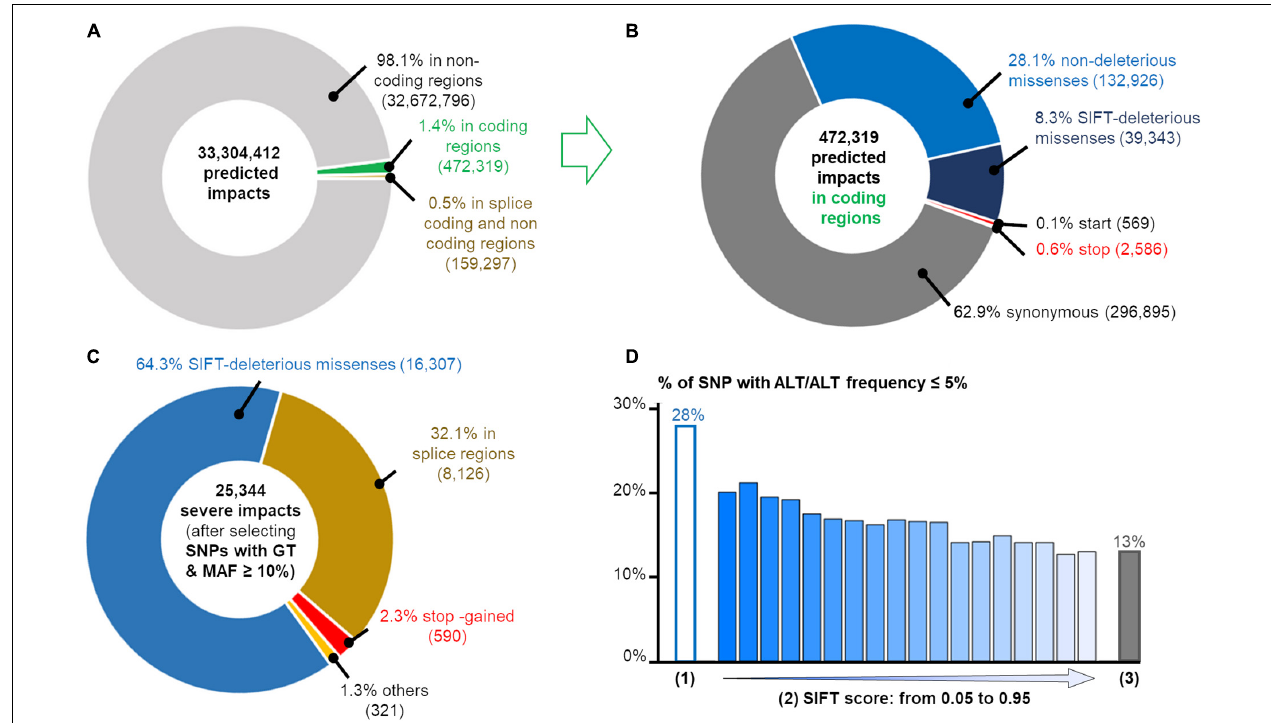
FIGURE 5 | Annotation of 9,496,283 SNPs using Variant effect Predictor (VEP) (McLaren et al., 2016). (A) Distribution of variant effect predictions among non-coding (light gray), splice regions related to coding and non-coding genes (orange) and coding (green) regions. (B) SNP annotation in coding regions: synonymous (dark gray), non-deleterious (light blue) and deleterious (blue) missenses, and consequences affecting stop (red) and start (orange) codons. Total number of consequences are indicated between parentheses. (C) Annotation of SNPs predicted as deleterious and filtered according to the GT criteria (as defined previously) and a MAF ≥ 10% in at least one population. (D) Percentage of SNP with a very low frequency ( ≤ 5%) of ALT/ALT genotype for three SNP sets: (1) = the 25,344 deleterious SNP described on the left; (2) = the tolerated SIFT-missense SNP according to the SIFT score and (3) = the synonymous SNP set. The splice sites correspond to the donor or acceptor splice sites of coding and long non-coding